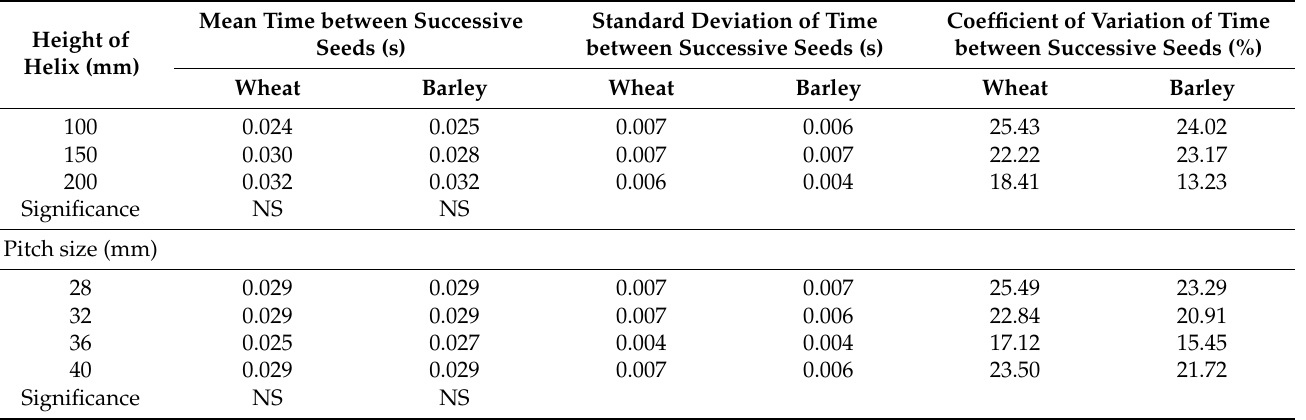
Table 6. The effect of the height of helix and pitch size of helicoidal seed tube on the time between successive seeds, standard deviation and coefficient of variation of time between successive seeds, according to results of laboratory tests.